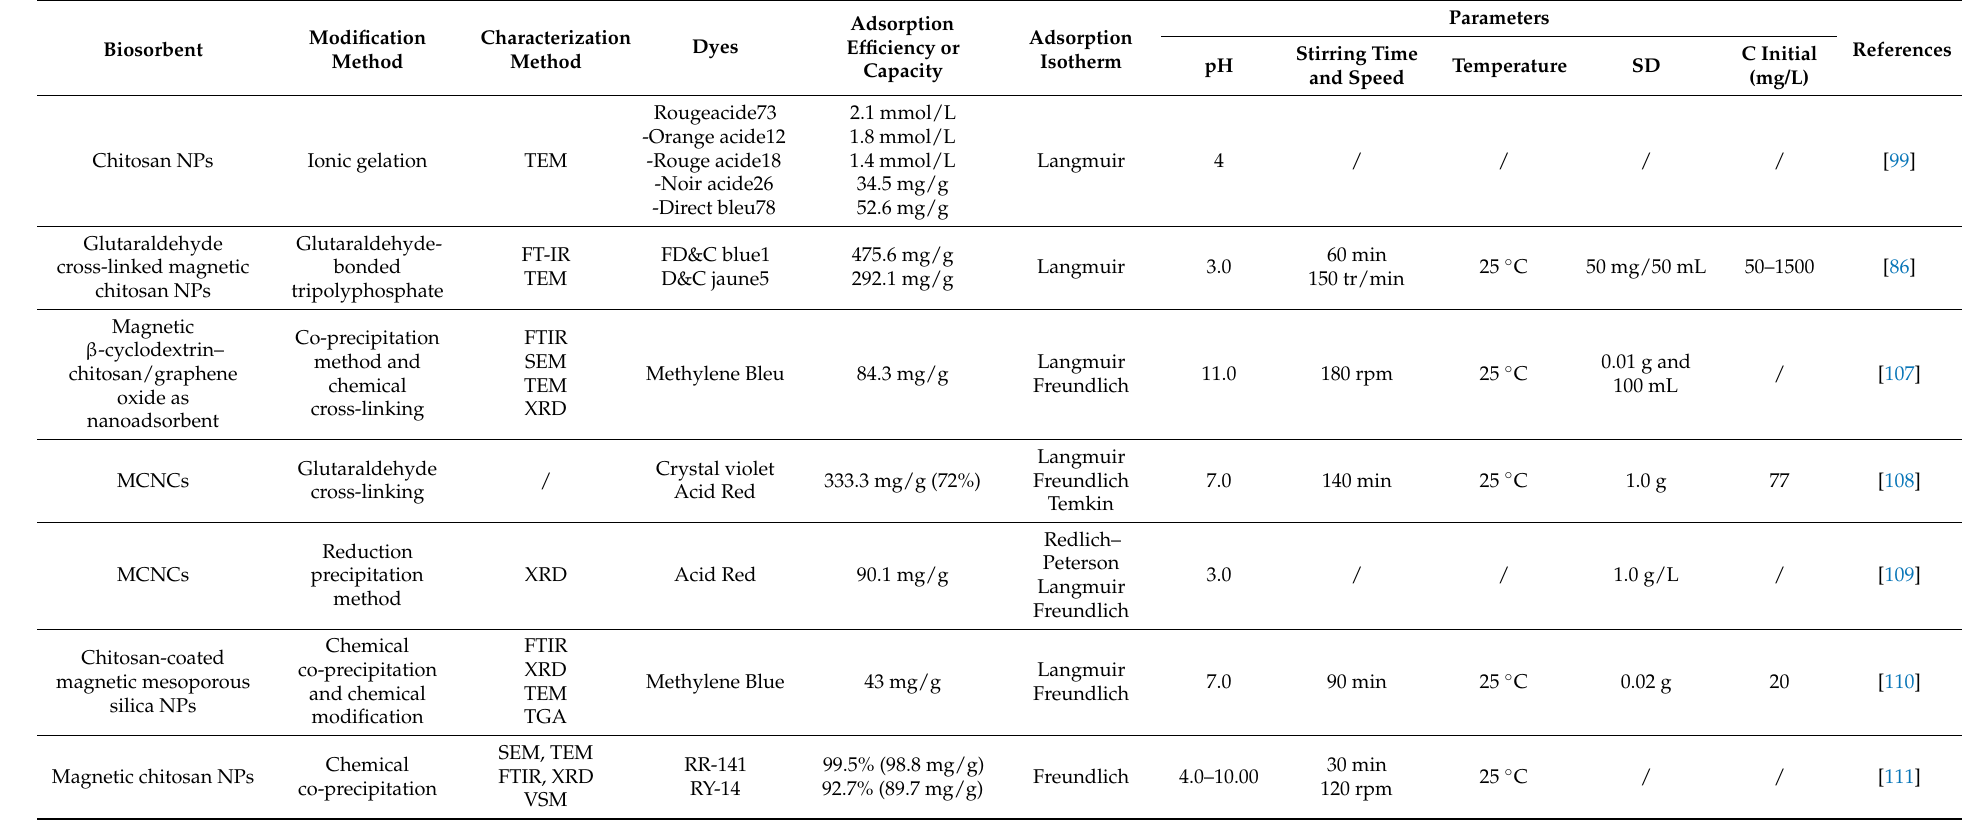
Table 3. Chitosan-based nanomaterials for dye